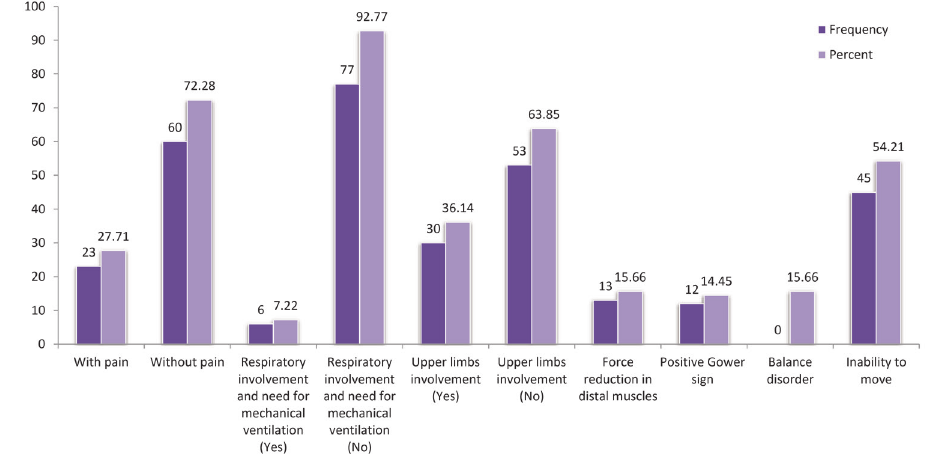
Figure 1. Frequency distribution of clinical symptoms of the studied